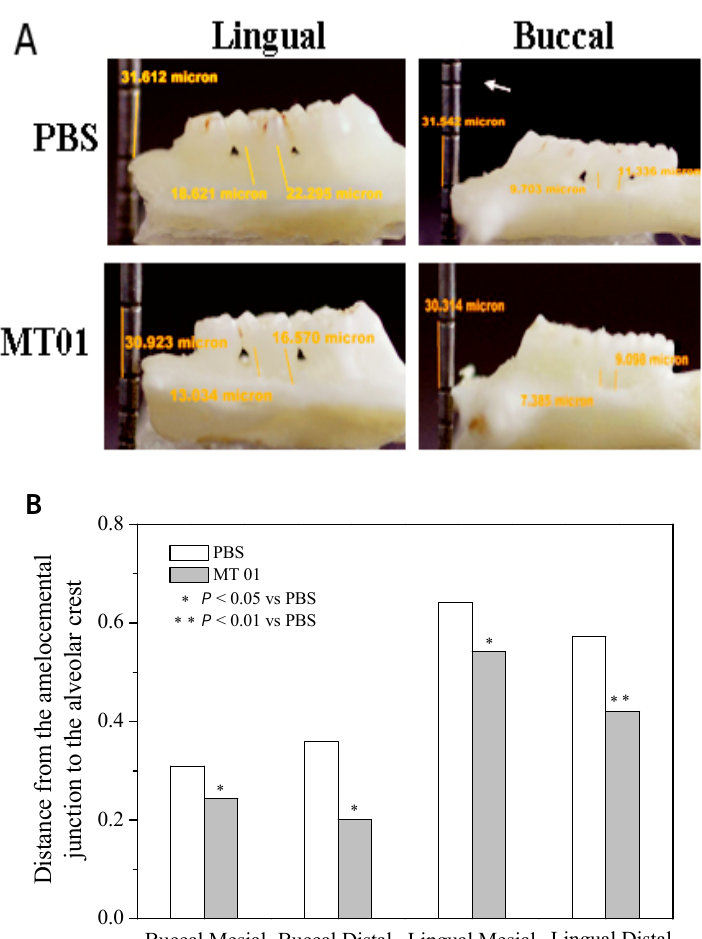
Figure 4. Influence of MT01 on alveolar bone loss in rat with periodontitis. Macroscopic aspects (Lingual and Buccal view) of the mandibles were observed. The yellow lines represented the distance from the amelocemental junction to the alveolar crest. ( A ) Analysis of the alveolar bone loss by SPOT RT software v3.5 [38,39]; ( B ) The extent of alveolar bone loss showed in the change of measurement between the control and MT01 treatment groups where n = 3 per group. * Indicates statistically significant difference ( P < 0.05) between MT01 and PBS. ** Indicates statistically significant difference ( P < 0.01) between MT01 and